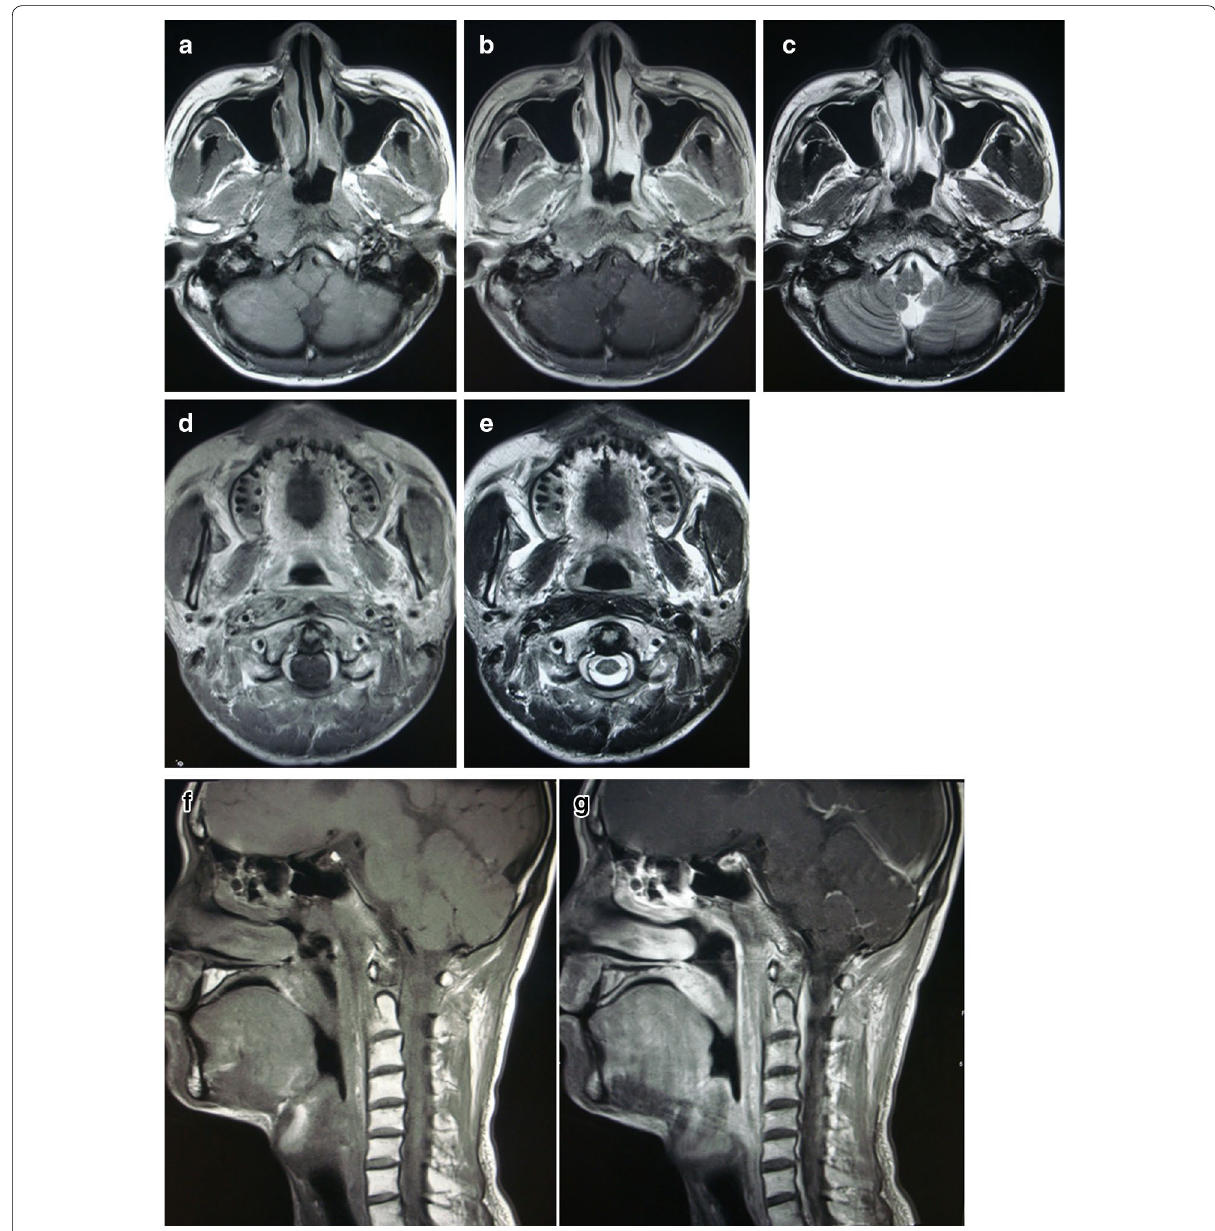
Fig. 3 MR imaging of the NPC patient at 3 months after treatment. T1‑weighted axial MR image of the nasopharynx a without contrast, b with contrast, and c T2‑weighted axial MR image of the nasopharynx show edema signal of the nasopharyngeal mucosa but no mass. T1‑weighted axial MR image d with contrast of previous occipital lymph node level and e T2‑weighted axial MR image of previous occipital lymph node level show normal structure now. T1‑weighted sagittal MR images f without contrast and g with contrast reveal no mass as